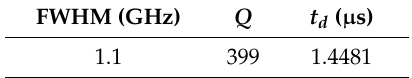
Table 5. Filter quality and performance parameters considering a distance between wires d = 18.5 µ m.